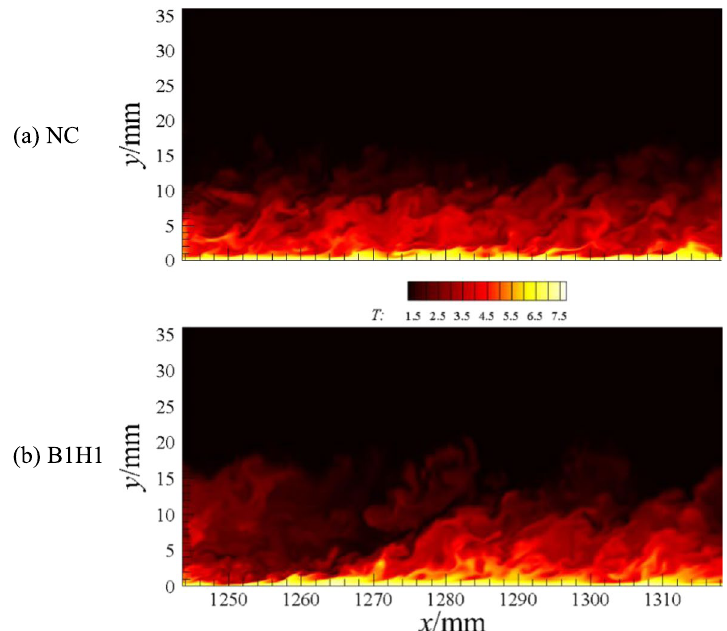
Fig. 14 Temperature contour in streamwise plane under different control methods